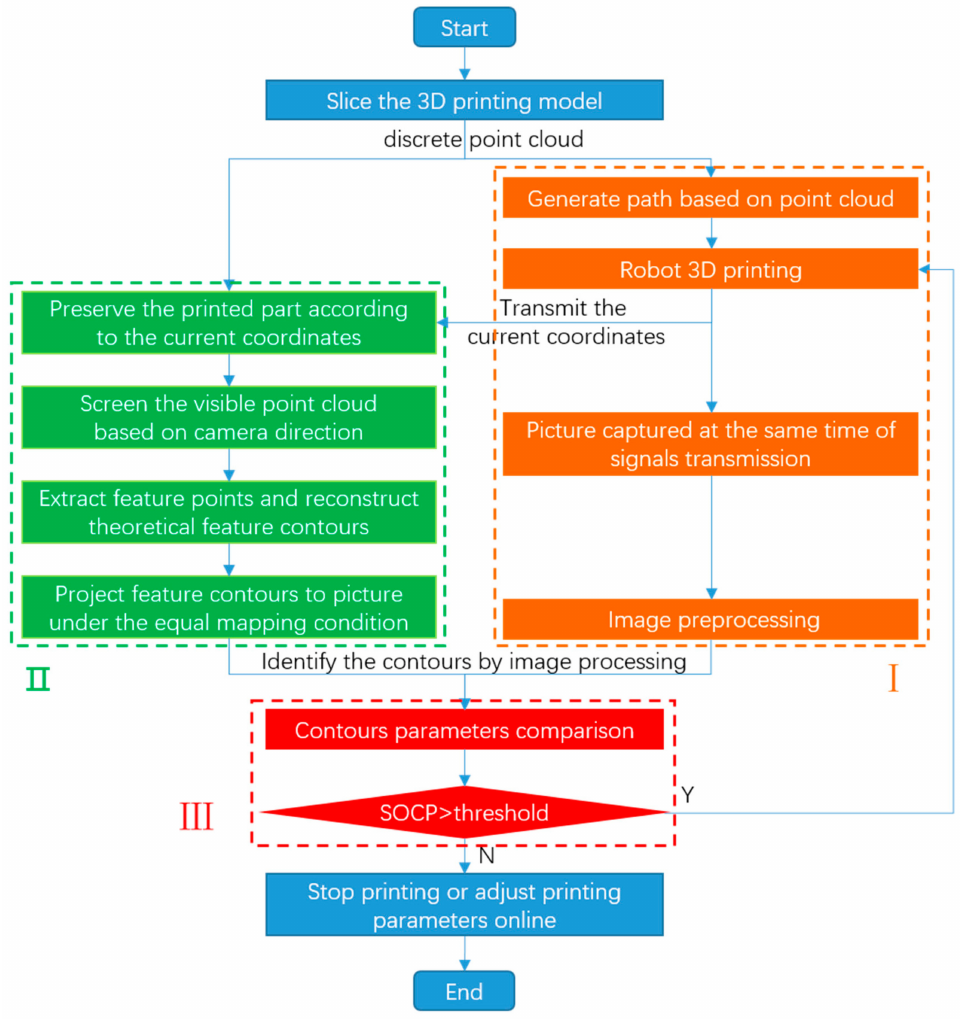
Figure 2. The flowchart of the visual detection algorithm of surface defects based on self-feature comparison in 3-D printing: I 3D printing processing steps; II Contour detection; III Identify defects and own